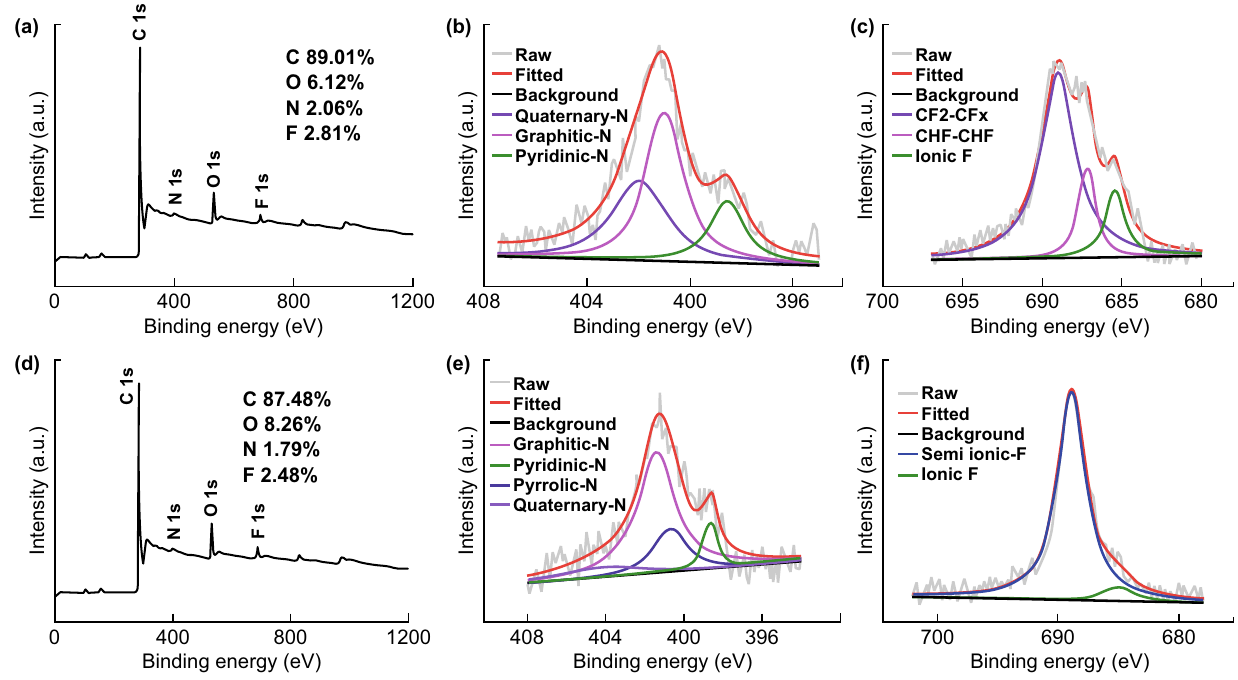
Fig. 3 a , d XPS spectra of N, F-MCFs-A and B. High-resolution XPS spectra of b , e N 1s and c , f F 1s of N, F-MCFs-A and